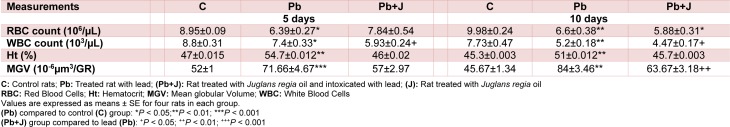
Hematological parameters analysis of adult rats treated with Pb and/or Juglans regia oil for 5 and 10 days